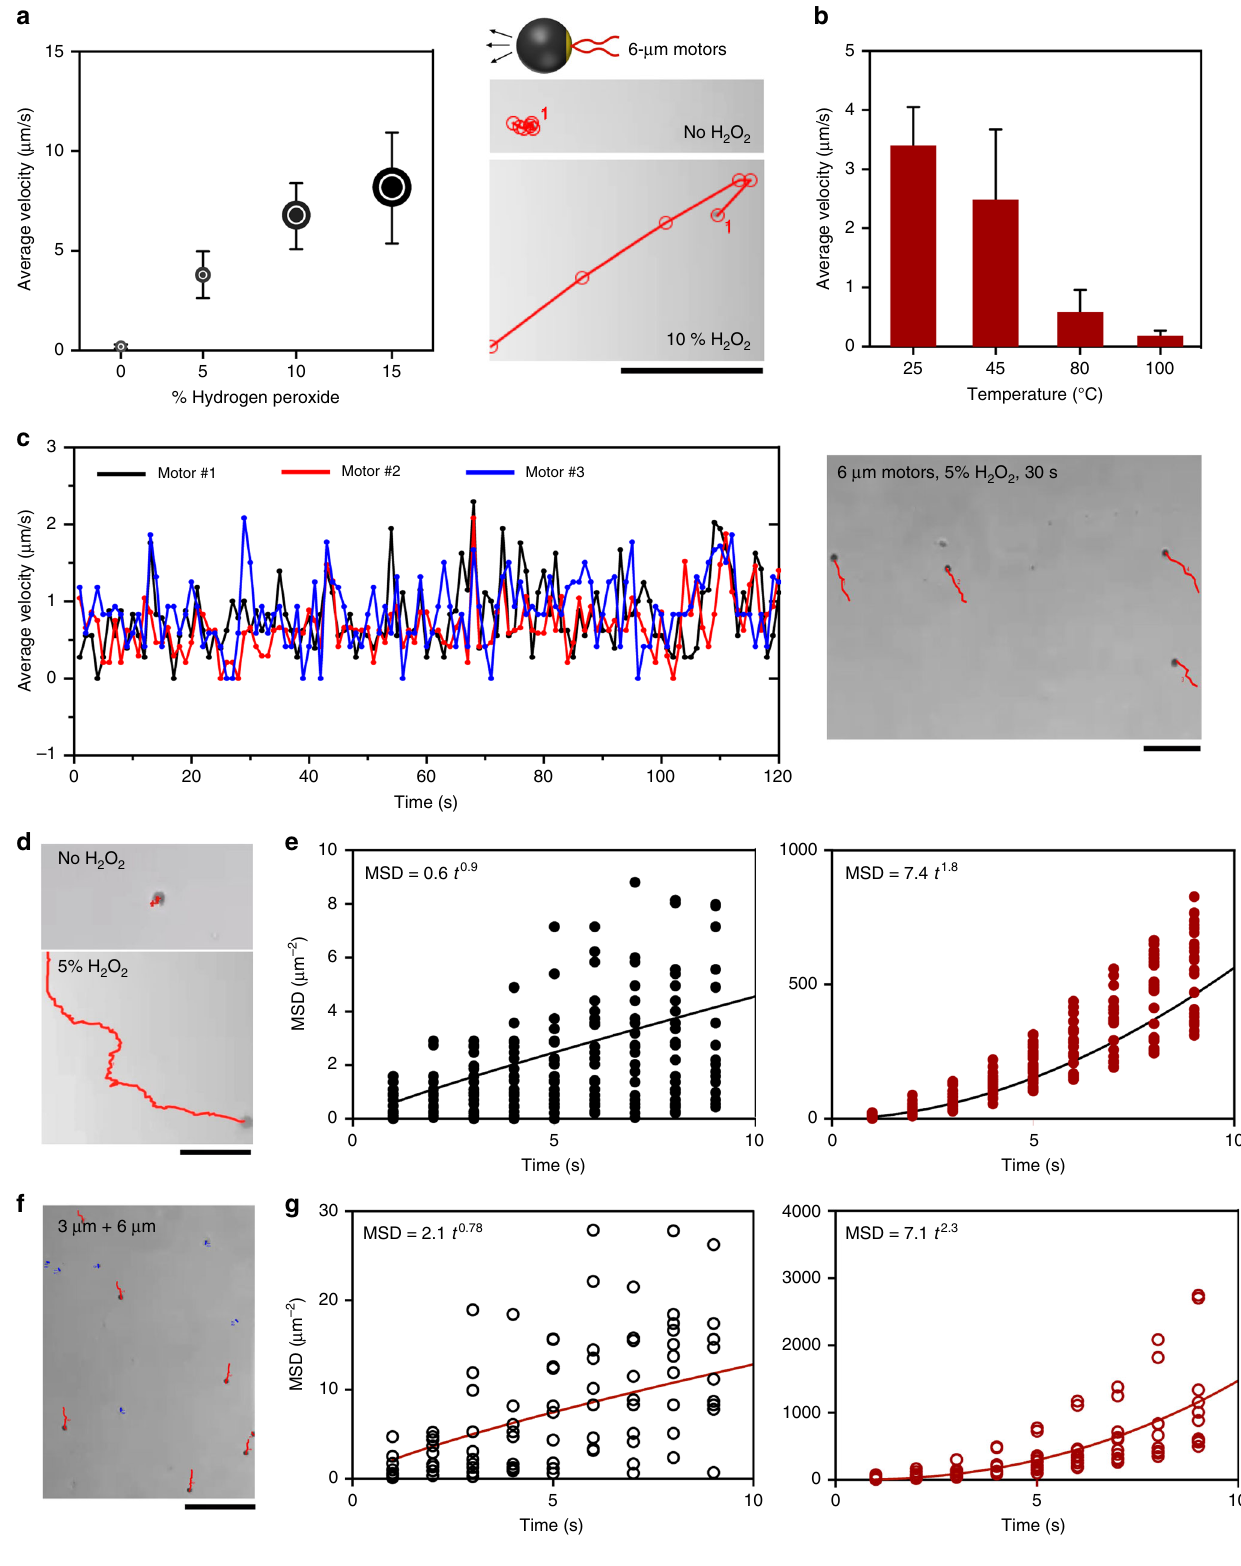
plot of the 3-μm beads and 6-μm Pt-motors suggests a funda- mentally different mode of motion (Fig. 3f, g and